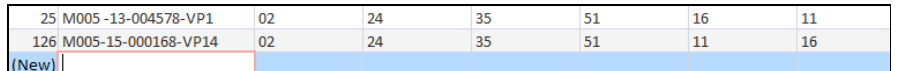
Figure 3. A screenshot of the filters tab that is available in each column of the “VP database” worksheet.